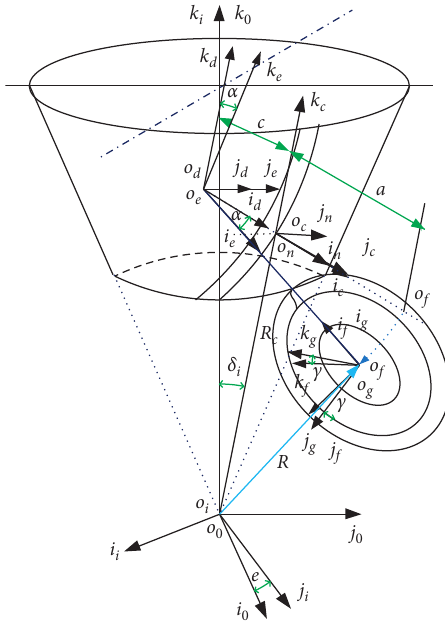
Figure 1: Machining coordinate system with disc milling